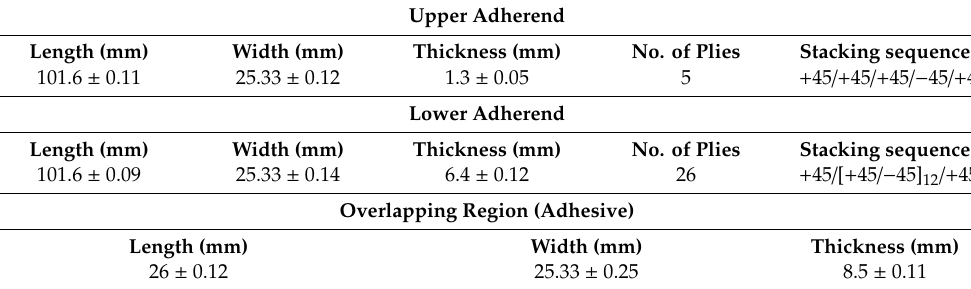
Table 2. SLS specimens’ geometry and